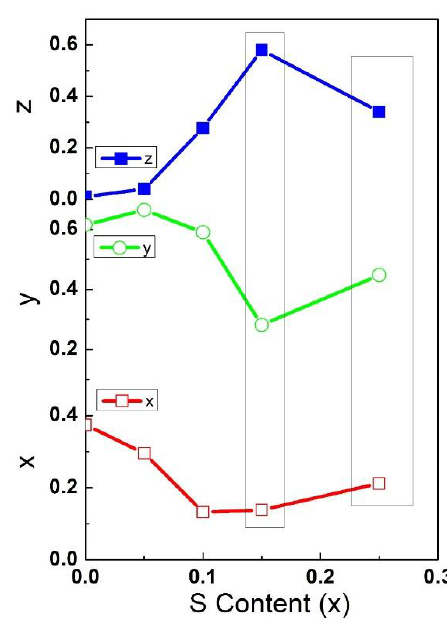
Figure 15. Variation of x , y , and z values against amount of S content.